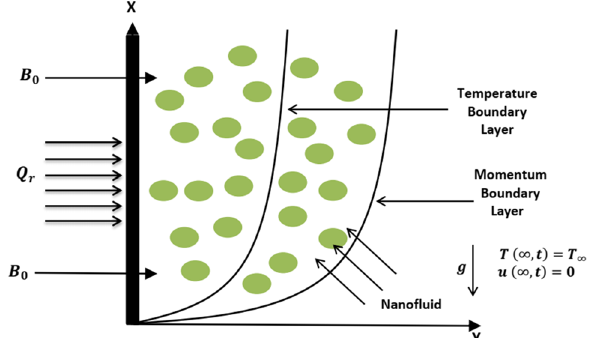
Figure 1. Geometry of the considered